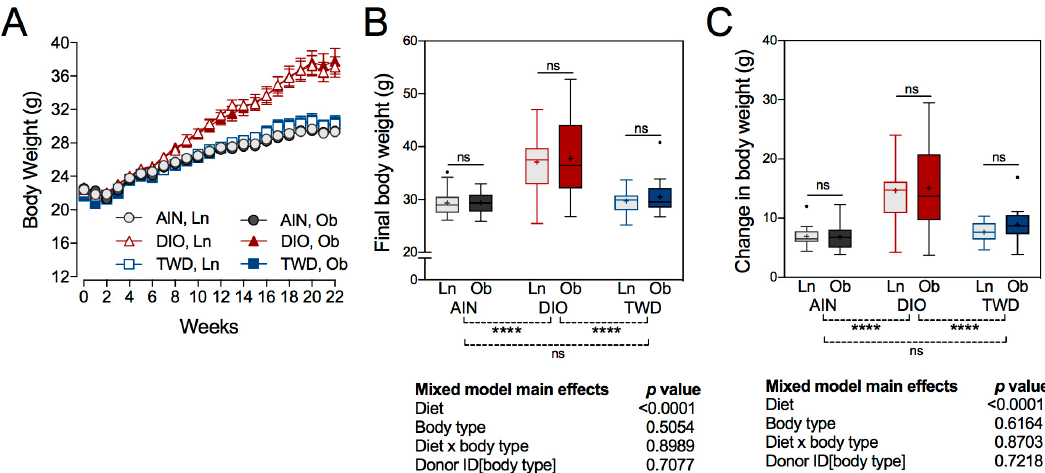
Figure 2. Body weight gain. ( A ) Body weight gain over the 22-week study period. Data shown are the mean ± standard error of measurement (SEM) for each group. ( B ) Final body weight and ( C ) change in body weight data are presented as Tukey box plots (box, 25th to 75th percentiles; whiskers, 1.5 interquartile range (IQR); +, mean) ( n = 6 to 9). The table to the right of this panel shows p -values for the main effects of each experimental factor as determined by the mixed model analysis. Below the plot, brackets indicate the results of Tukey post hoc tests for the overall effects of each diet. Within each diet group, symbols above the box and whisker bars indicate the results of post hoc tests comparing mice that received bacteria from lean (Ln) or obese (Ob) human donors. **** p < 0.0001, ns = not significant.